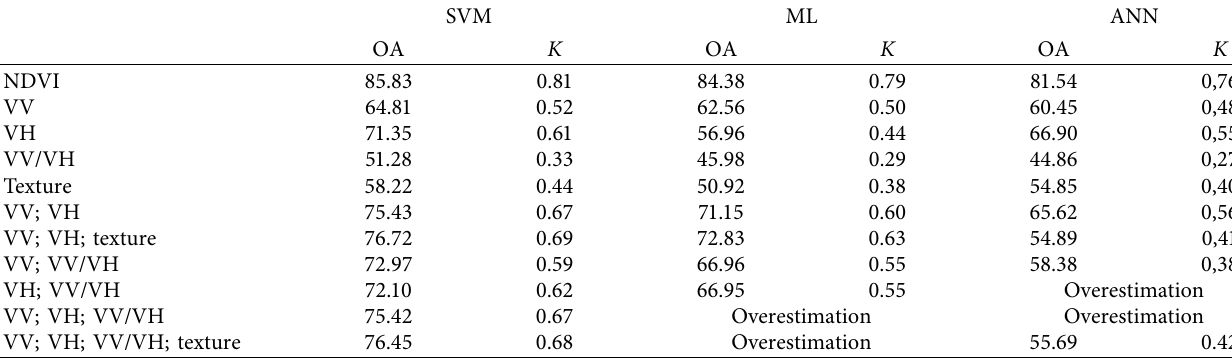
Table 4: Overall accuracies and Kappa coefficients of noncombined scenarios.